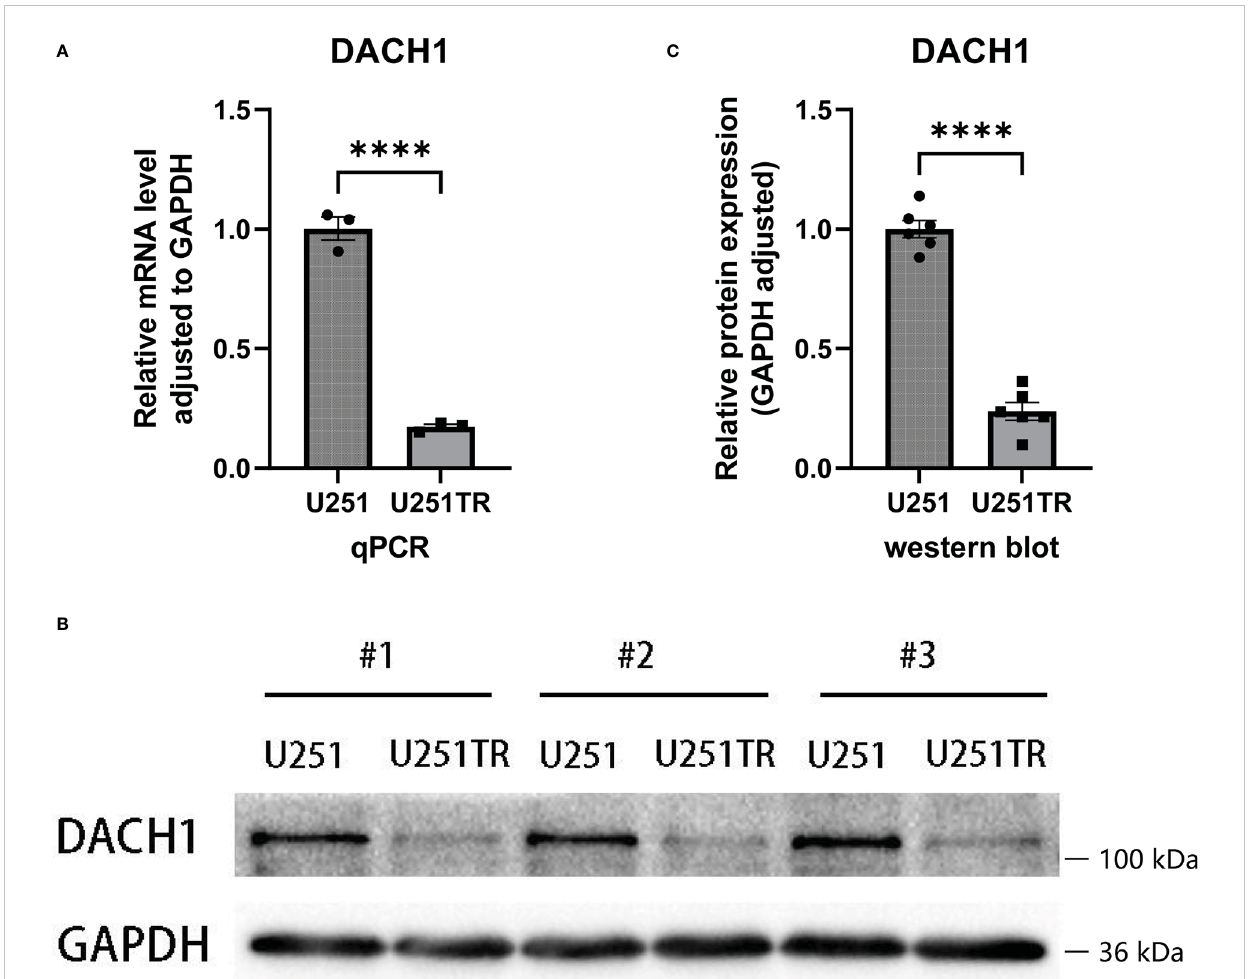
FIGURE 7 (A) The results of PCR experiments indicated that the relative RNA expression of DACH1 (adjusted to GAPDH) was signi fi cantly higher in the U251 group than in the U251TR group (P < 0.05). (B) The results of western blot experiments indicated that the gray degree of DACH1 was signi fi cantly higher in three U251 clones than in three U251TR clones. (C) The statistical results of the gray values show that the relative protein expression of DACH1 (adjusted to GAPDH) was signi fi cantly higher in the U251 group than the U251TR